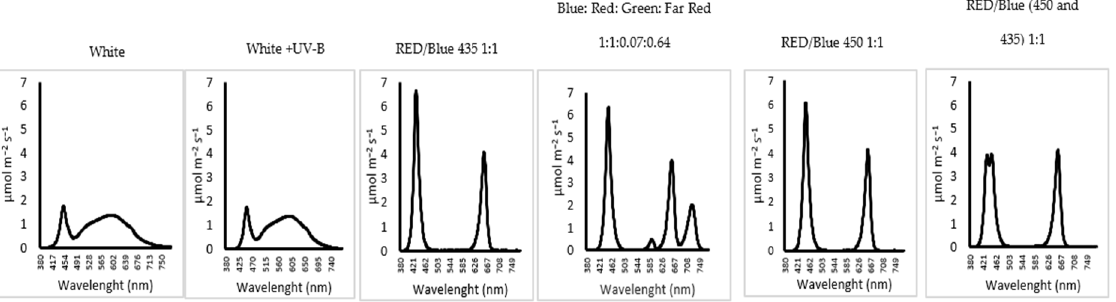
Table 1. The relative ratio of light spectrum in the applied treatments (R refers to red, B refers to blue, W refers to white, G refers to green, FR refers to far-red and UV to ultraviolet.